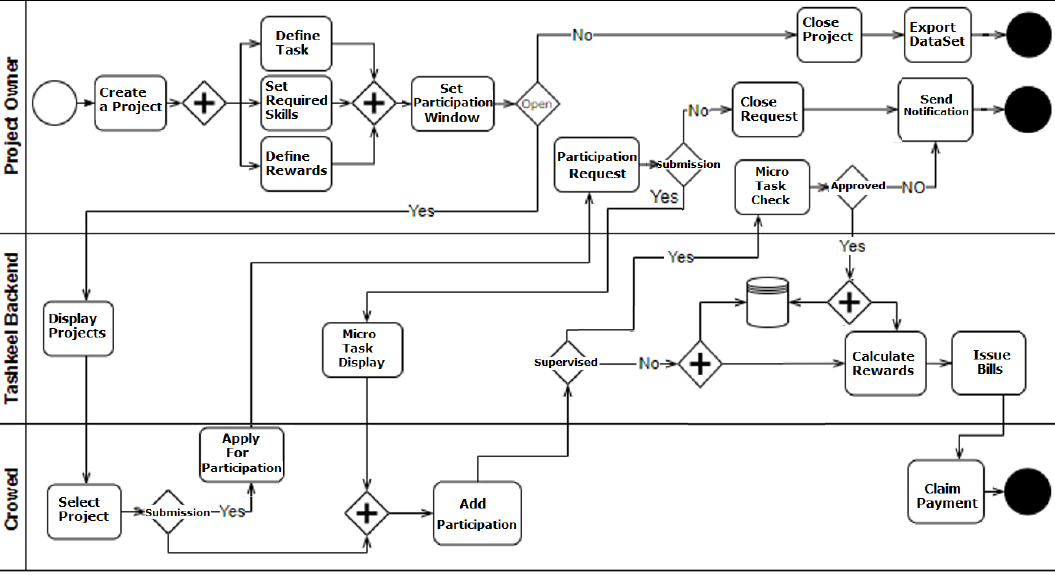
Figure 2. Tashkeel’s main workflow in a Business Process Model and Notation (BPMN) diagram.